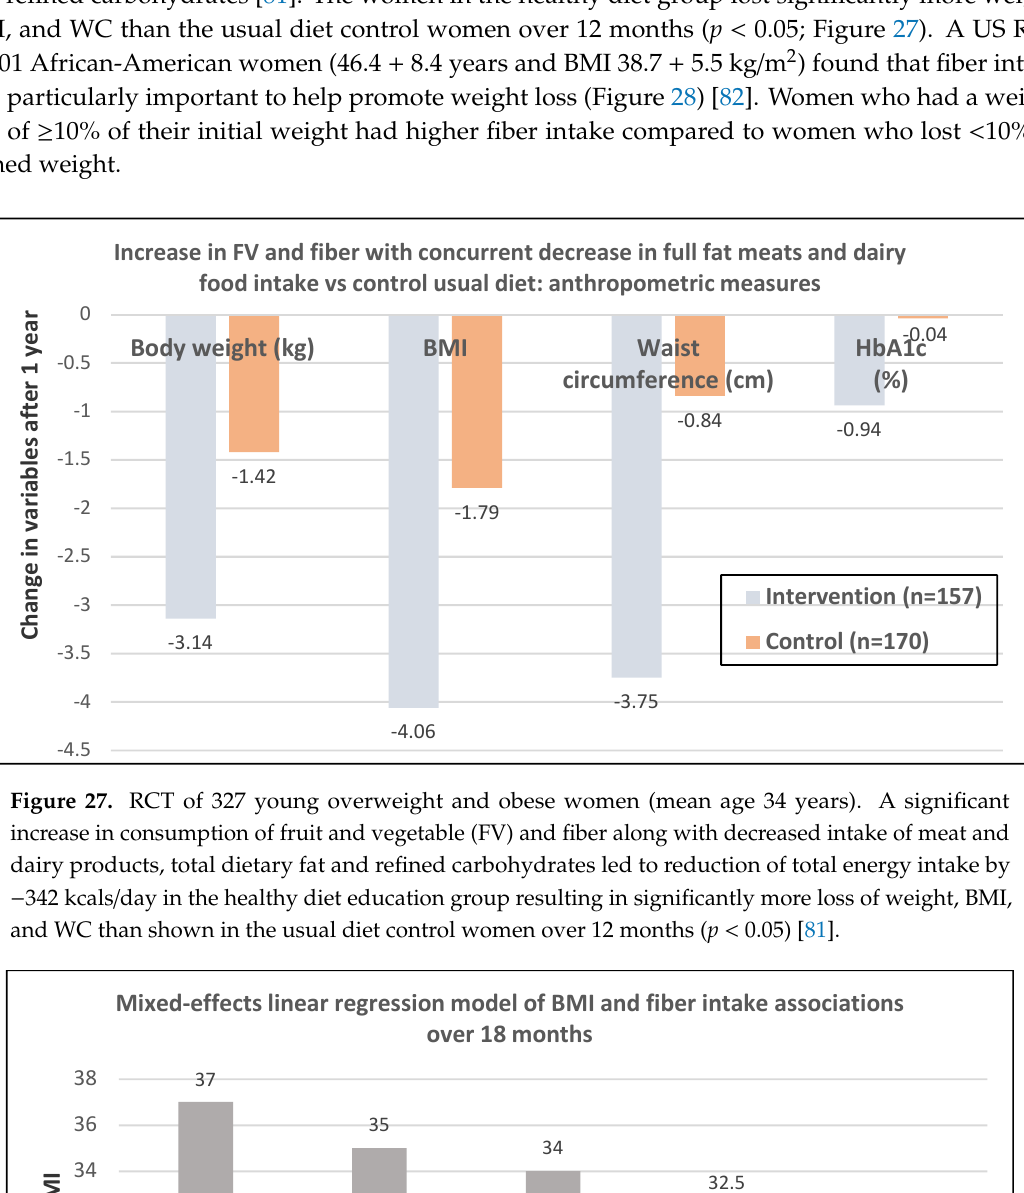
Table 1. Comparison of the dietary fiber content and its food sources for Western vs. healthy diets per 2000 kcals (approx. values) [2,40].